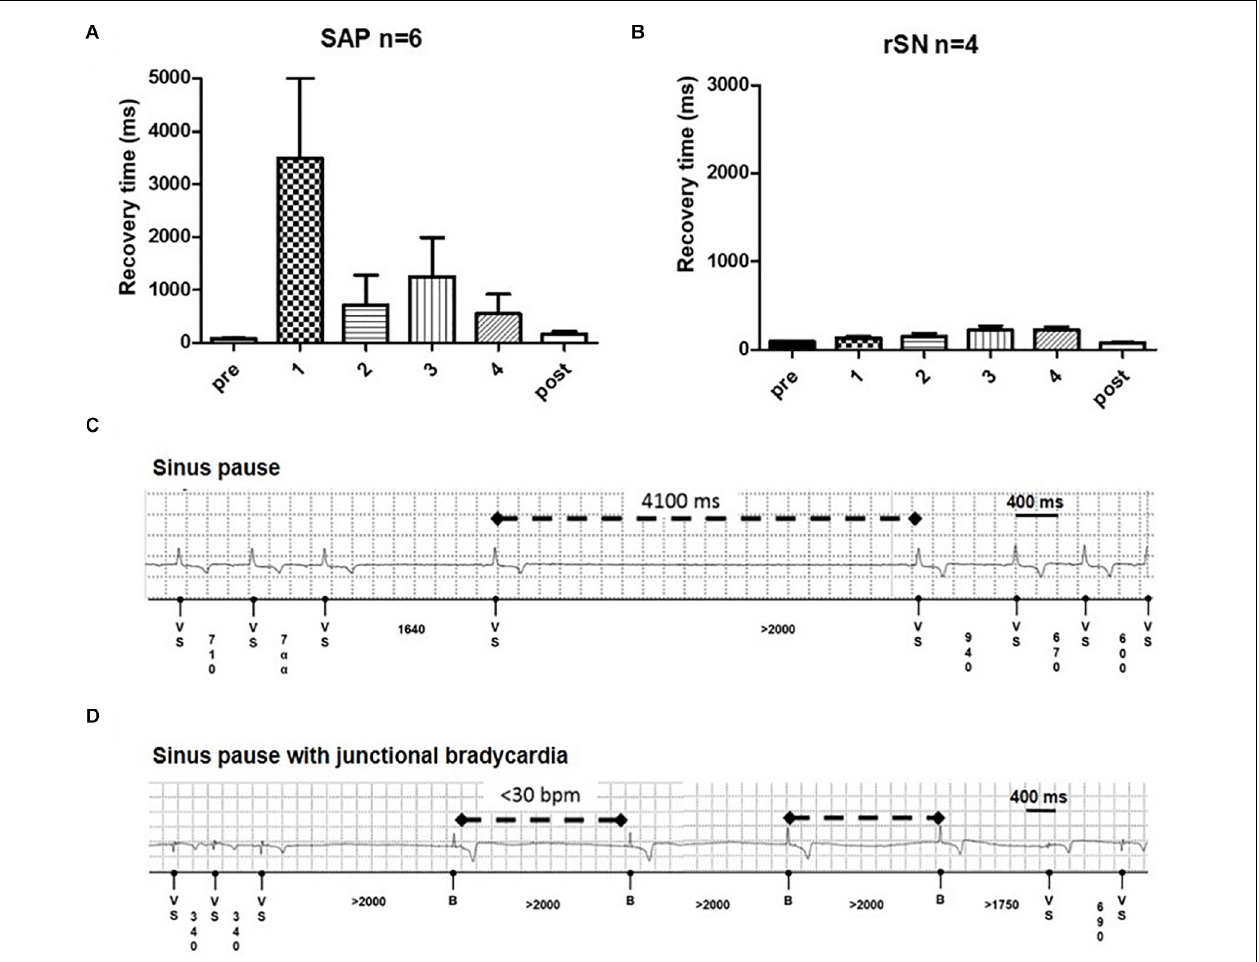
FIGURE 8 | Recovery time and junctional events on long term. (A) Subsidiary atrial pacemaker (SAP) group ( n = 6) shows a profound recovery time (CART) prolongation in the first week of follow-up (* p = 0.04). (B) No such prolongation is detectable in the recovered sinus node (rSN) group ( n = 4). From the second week on, the CART values diminished and became no longer significantly longer than sinus node recovery time (SNRT) at baseline. Examples of (C) profound sinus pause and (D) sinus pause with junctional bradycardia in ablated